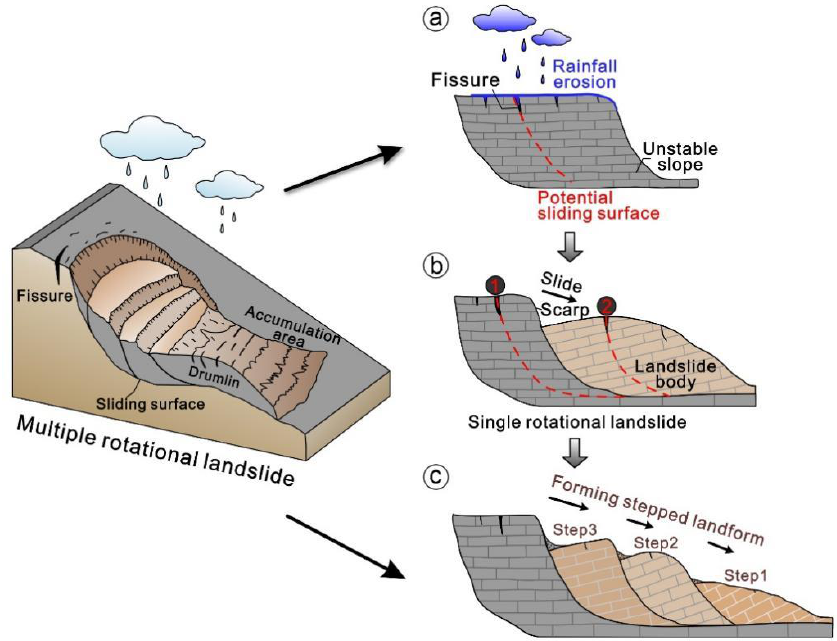
Figure 13. Evolution of multiple rotational landslides. Two kind of potential sliding surfaces occur based on fissures from the single rotational landslide to multiple rotational landslides. ( a ) Unstable slope. ( b ) Single rotational landslide. ( c ) Multiple rotational landslides.